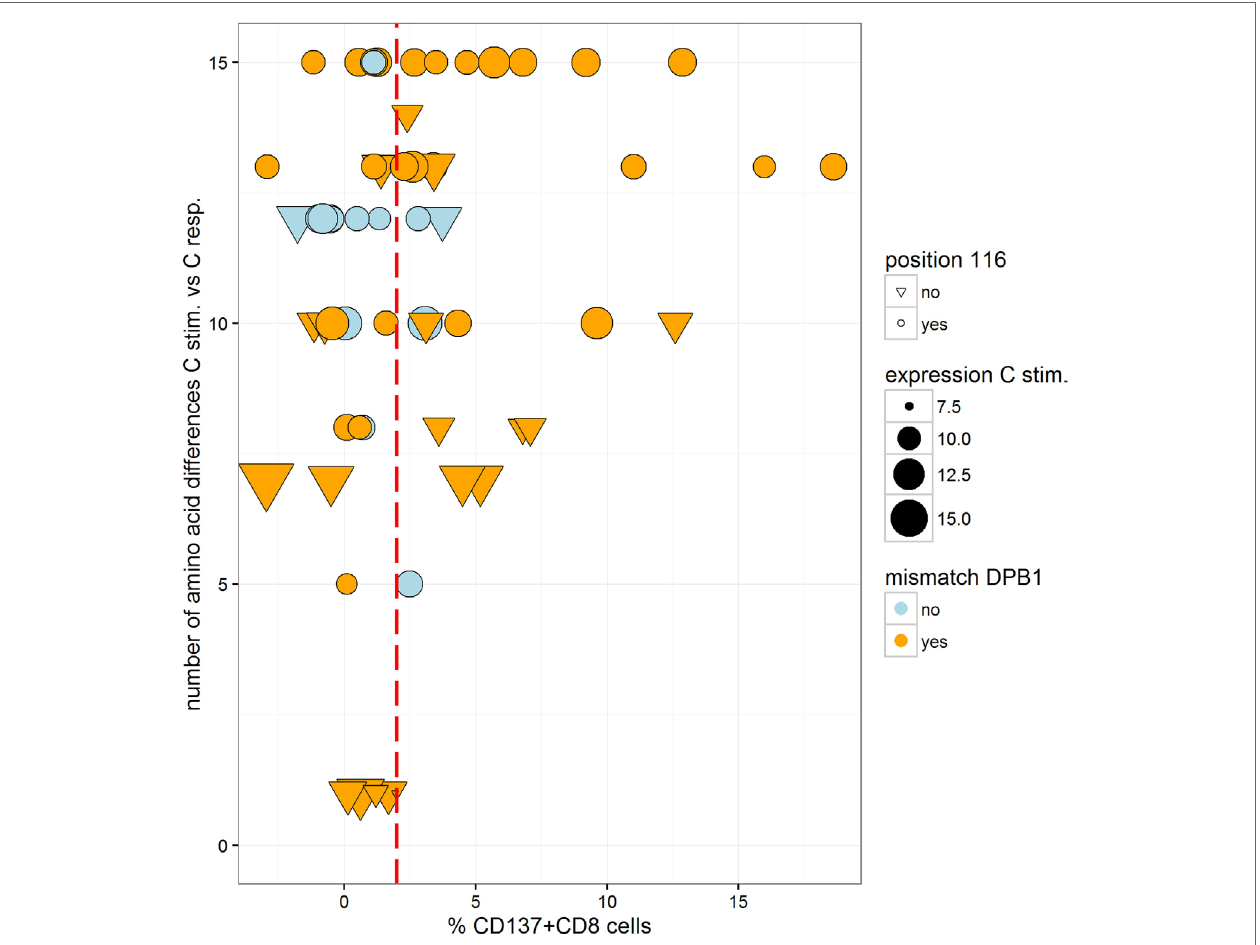
FigUre 5 | scatter plot of the number of mismatched residues at hla-c between the stimulator and the responder allele and alloreactivity (% Δ cD137 + cD8 + cells) . Information on several predictor variables is plotted: matching at HLA-DPB1 is indicated by two different colors (blue for matched and orange for mismatched HLA-DPB1), mRNA expression of the stimulator HLA-C allele is indicated by the size of the dots, while variation at position 116 is indicated by the shape of the dots (a reversed triangle for matched and a circle for mismatched). The cutoff value considered for positive/negative alloreactivity is shown by the red dotted